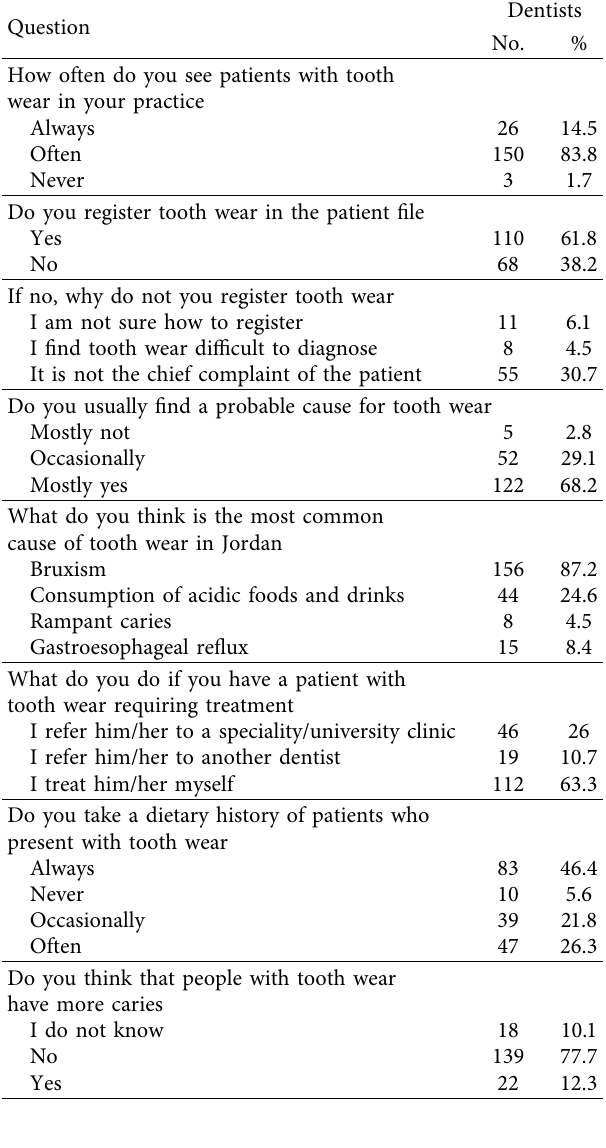
Table 1: The distribution of dentists according to age, gender, speciality, qualification, work place, and years of experience.